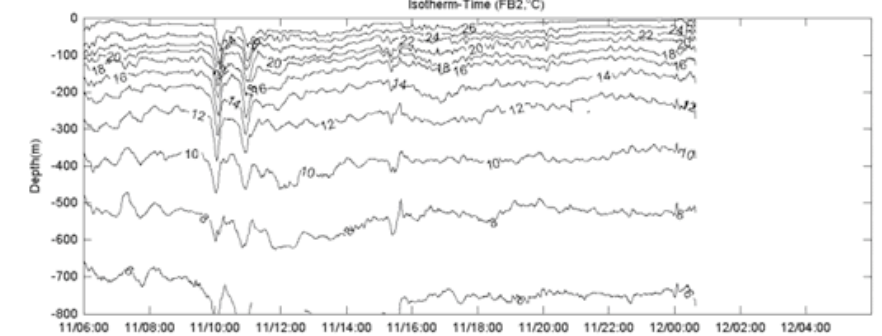
Fig. 8. Displacement of the isotherms as measured in the South China Sea, from Liu et al. (2006).